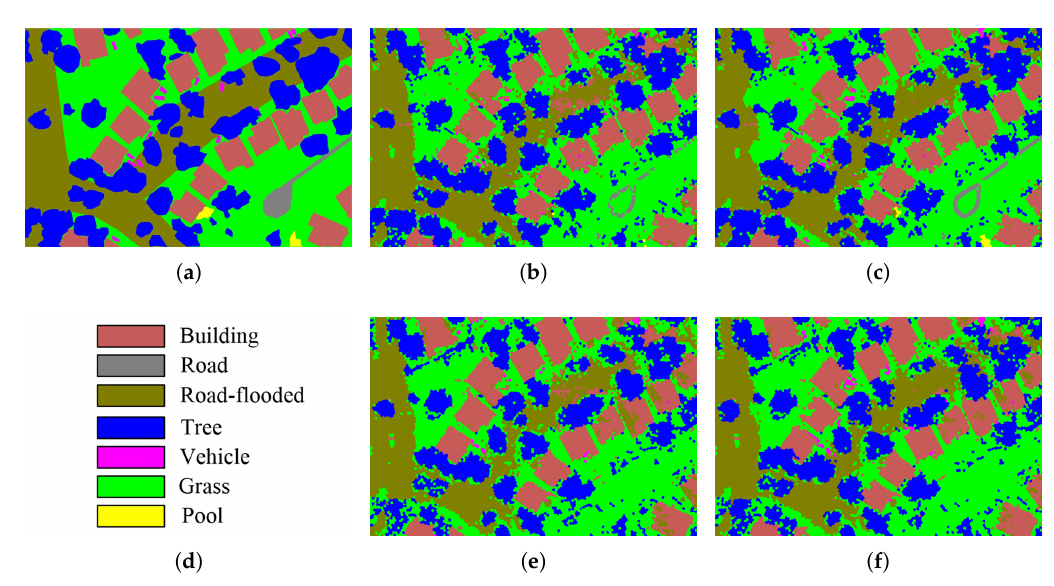
Figure 7. Classification maps generated from FloodNet-7577: ( a ) ground truth; ( b ) XGB + BT;